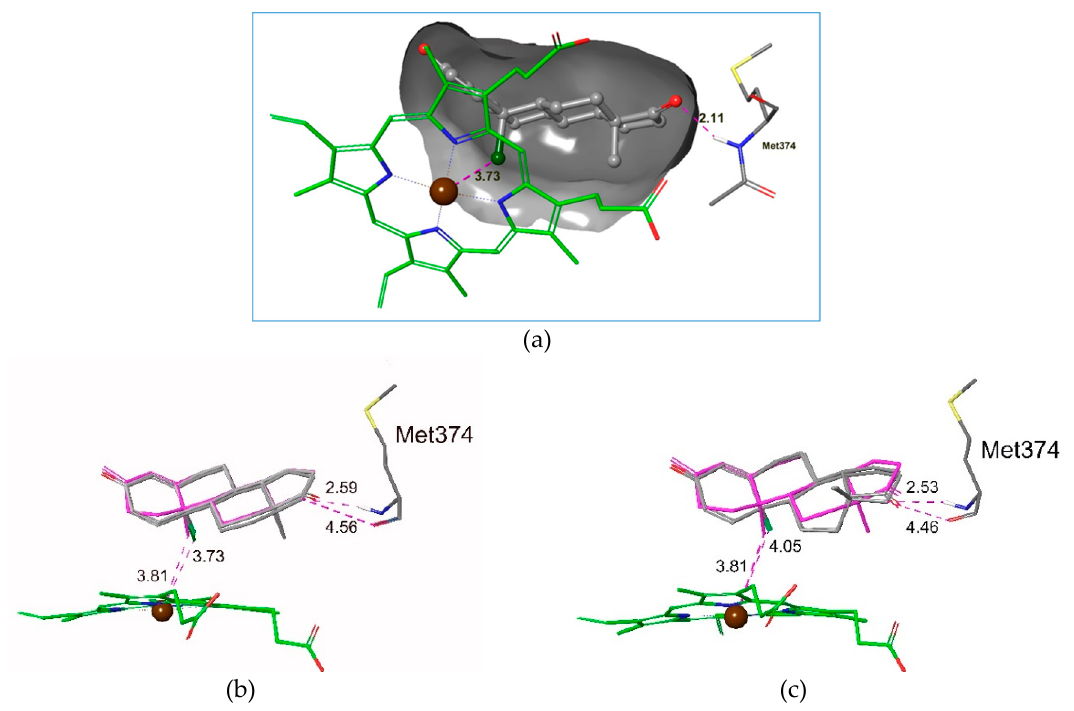
Figure 3. ( a ) The binding pose of ligand 22 with the best Emodel score. Distances are presented in Å. ( b ) The best binding pose of the biologically active ligands ( 9 , 20 , and 22 ) with the original X-ray ligand (molecule with purple line) pose. ( c ) The best binding pose of the biologically inactive ligands ( 17 and 21 ) with the original X-ray ligand (molecule with purple line) pose.